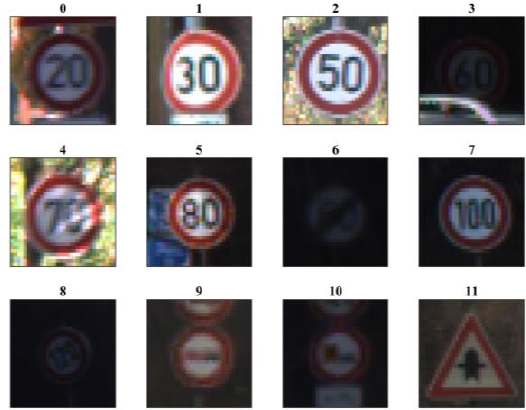
Figure 6. Example GTSRB dataset images. (Digits indicate class labels.)